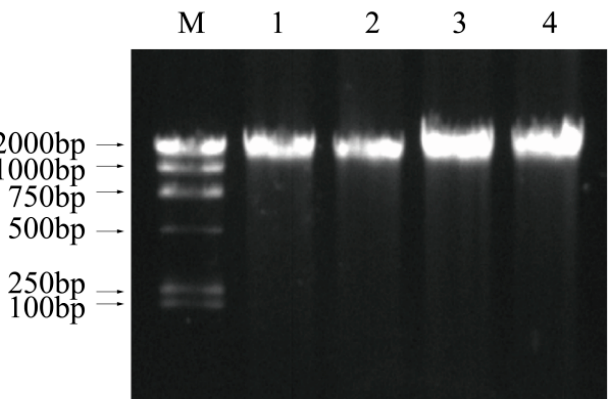
Figure 5. DNA fragmentation profiles of DNA extracted from Vibrio parahaemolyticus . Lane: M, λ /HindIII DNA marker; 1, untreated; 2, treated with 405 nm LED irradiation for 30 min; 3, treated with 0.1 mg/mL of citral for 30 min; 4, LED treatment combined with 0.1 mg/mL of citral for 30 min.